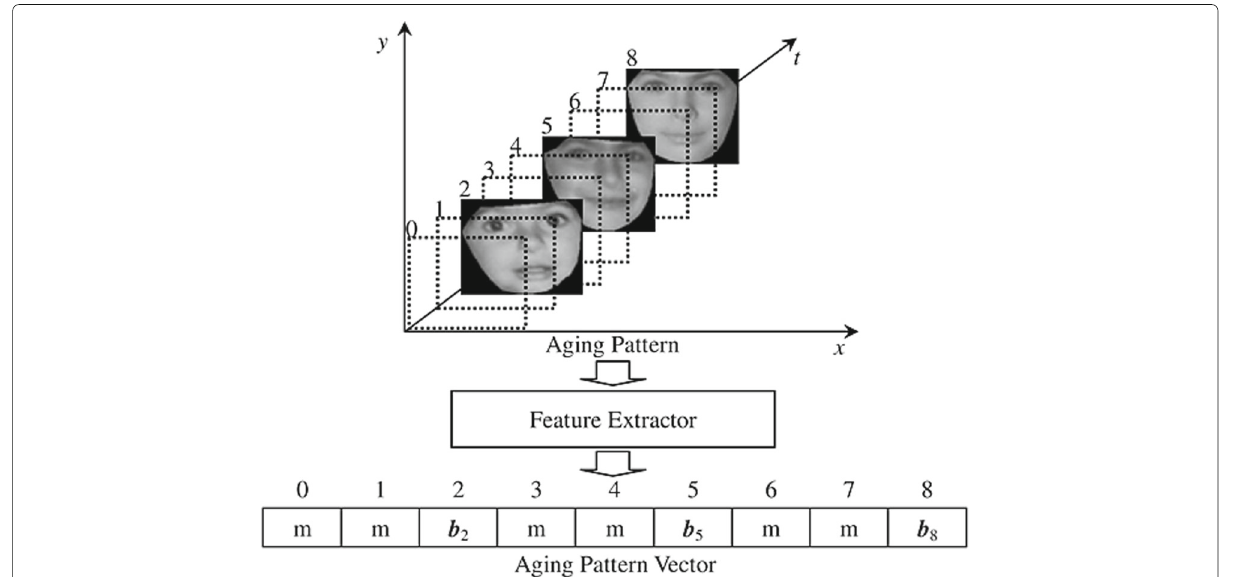
Fig. 5 Aging pattern vectorization. Age is marked at the top-left corner of the corresponding feature